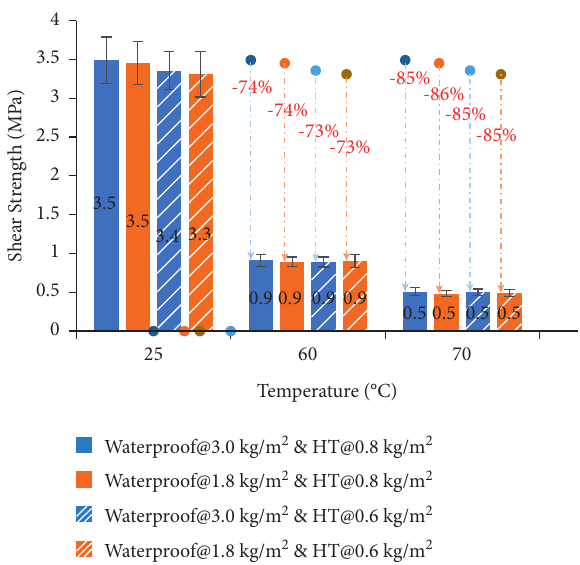
Figure 12: Inclined shear test results in terms of different material densities.